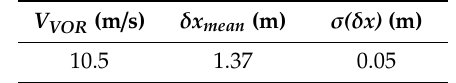
Table 4. Estimated δ x mean to V VOR , and its standard